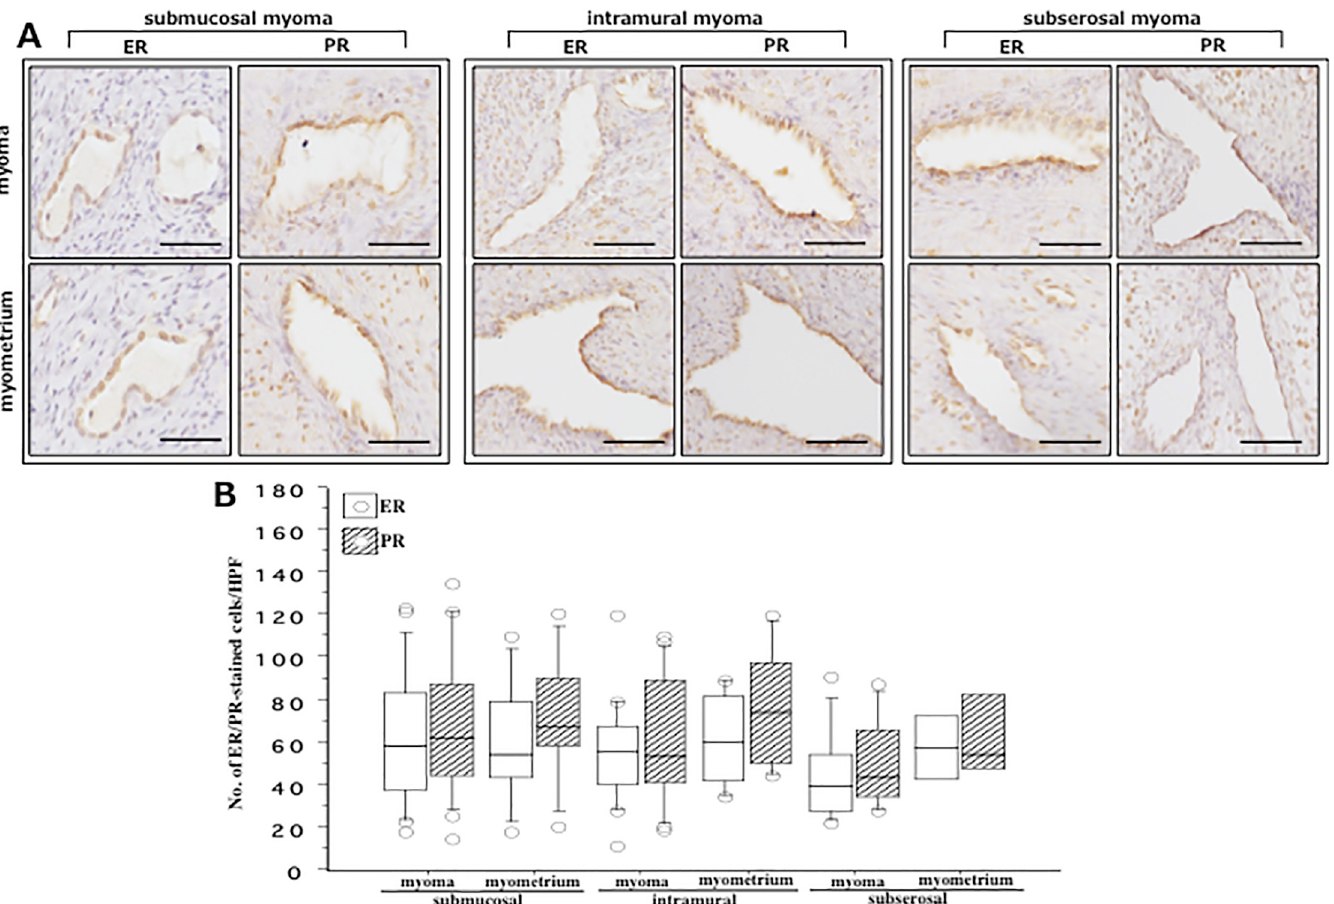
Fig 2. (A) Immunohistochemical staining of estrogen receptor (ER) and progesterone receptor (PR) in vascular endothelial cells (VECs) detected in biopsy samples derived from myoma (upper row) and adjacent myometria (lower row) of women with submucosal myoma (left panel), intramural myoma (middle panel) and subserosal myoma (right panel). Scale bar = 50 μ m for each slide. (B) Shows number of estrogen receptor (ER, white box)- and progesterone receptor (PR, hatched box)- immunostained VECs within myoma and adjacent myometria derived from these three groups of women. There was no significant difference between ER-and PR- stained VECs in either myoma or myometria derived from three types of fibroids. The boxes represent the interquartile ranges and horizontal lines in the boxes represent median values. HPF, high power field (x200).